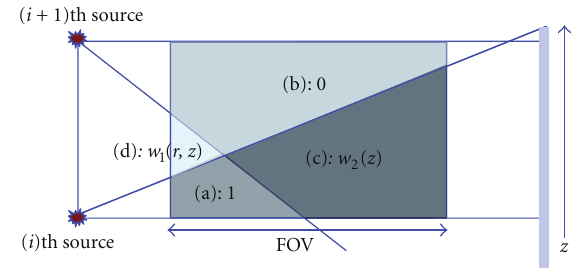
Figure 8: Multi-source half-scan regions at a given fan angle: (a) a region illuminated by only ( i )th source, (b) a region illuminated by only ( i + 1)th source, (c) a region illuminated by both ( i )th and ( i + 1)th sources, and (d) a region without